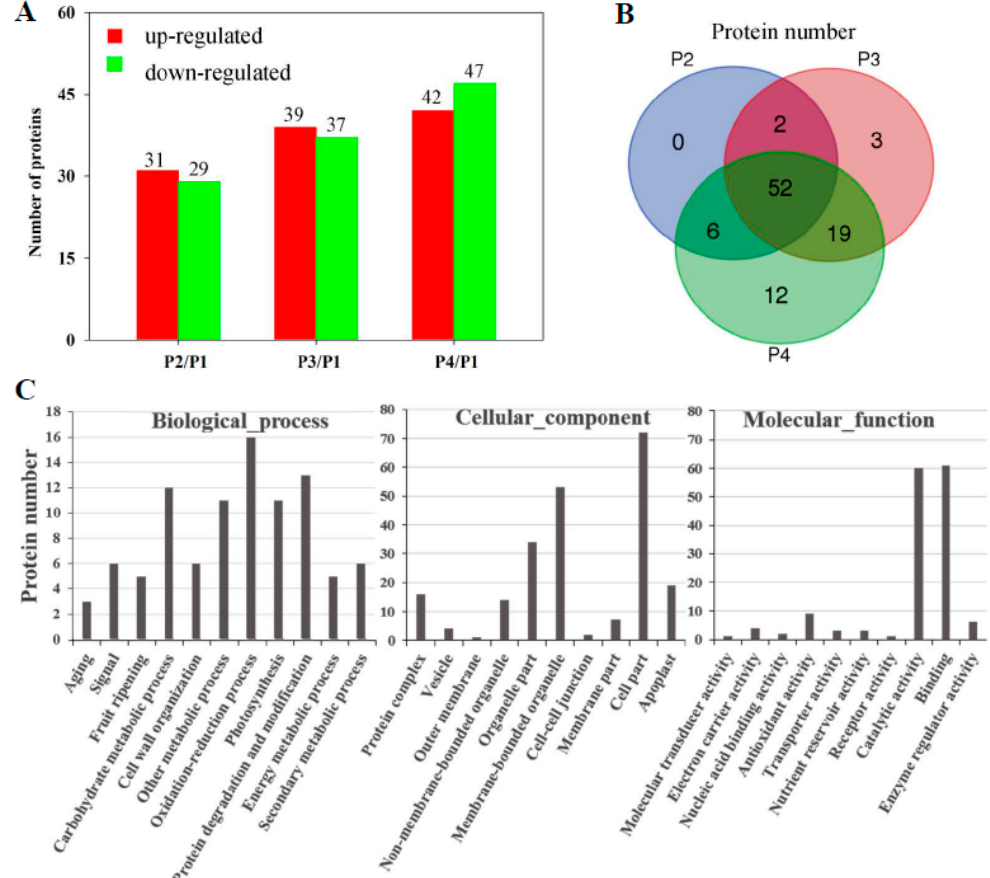
Figure 4. Di ff erentially expressed proteins in the peel of banana fruit at di ff erent stages of ripening. Comparative proteomics of banana peel were performed using 2-DE coupled matrix-assisted laser desorption / ionization time-of-flight tandem mass spectrometry (MALDI-TOF MS / MS). ( A ) Numbers of di ff erentially expressed proteins. The numbers of up-regulated proteins and down-regulated proteins are indicated with red and green color, respectively; ( B ) Venn diagram illustrating the corresponding numbers of di ff erentially expressed proteins at di ff erent stages of ripening; ( C ) gene ontology term assignments based on significant plant species hits against the NR database, according to the biological process, molecular function, and cellular